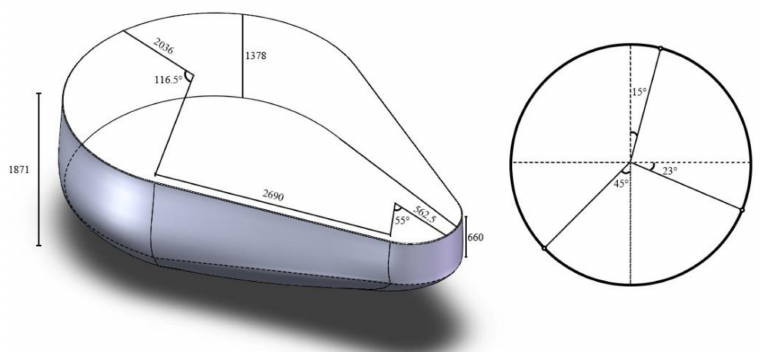
Figure 1. Geometric parameters and bottom blowhole arrangement of the Electric arc furnace (EAF). In the geometric model, the diameter of the reference circle on the top surface of the eccentric area was 1374 mm, the diameter of the reference circle on the top surface of the main body of the EAF was 4072 mm, the diameter of the bottom circle of the main body of the EAF was 2122 mm, and the furnace length of the EAF was 6355 mm. The length of the hypotenuse was 2690 mm, and the actual fan angles at the top of the EAF model were 233 ◦ and 110 ◦ , respectively. The bottom-blowing hole has a hydraulic radius of 10 mm and is arranged on a circumference of 1001.1 mm from the center; the hydraulic radius of the molten pool was 5481 mm, the depth was 1650 mm, the internal molten steel depth was 1430 mm, and the thickness of the slag phase was 165 mm. The number of meshes in the mesh model established based on the geometric model was 55,924, and the number of nodes was 540,395 [31] (Figure 2).